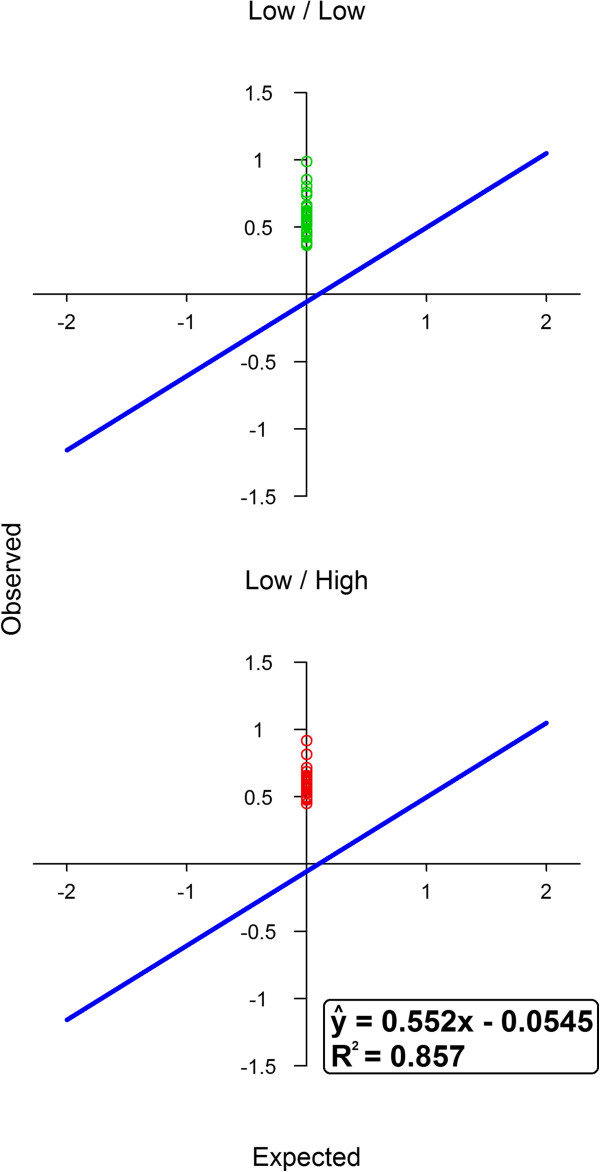
Allele-specific expression analysis. Ratios of C:T cDNA expression levels in testis from heterozygous animals for exonic variation in SULT2A1. Heterozygous animals’ diplotypes are indicated in the titles (low/low, low/high). Standard curve fitted to all control samples (blue line) and its regression equation and coefficient of determination are shown.